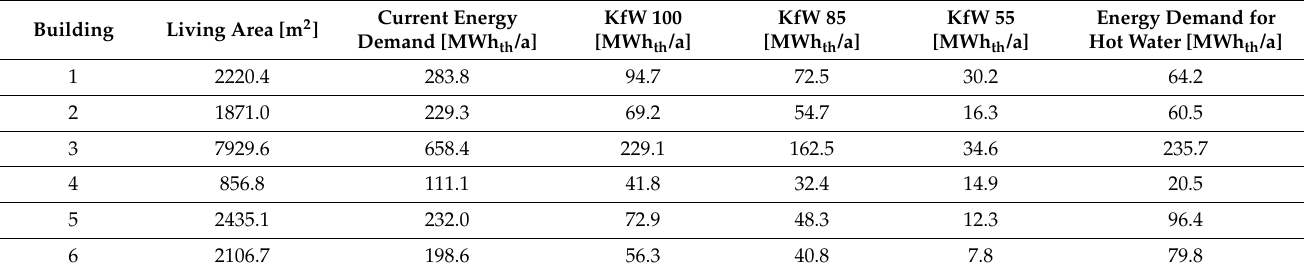
Table 1. Overview and key data of buildings included in the case study (check Appendix A Figure A1 for more details).